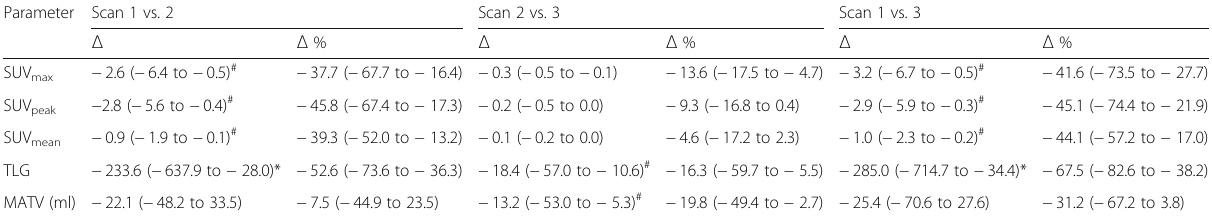
Table 4 Changes in metabolic tumor activity for the VOI man during the neoadjuvant treatment between the serial 18 F-FDG PET-CT scans Parameter Scan 1 vs. 2 Scan 2 vs. 3